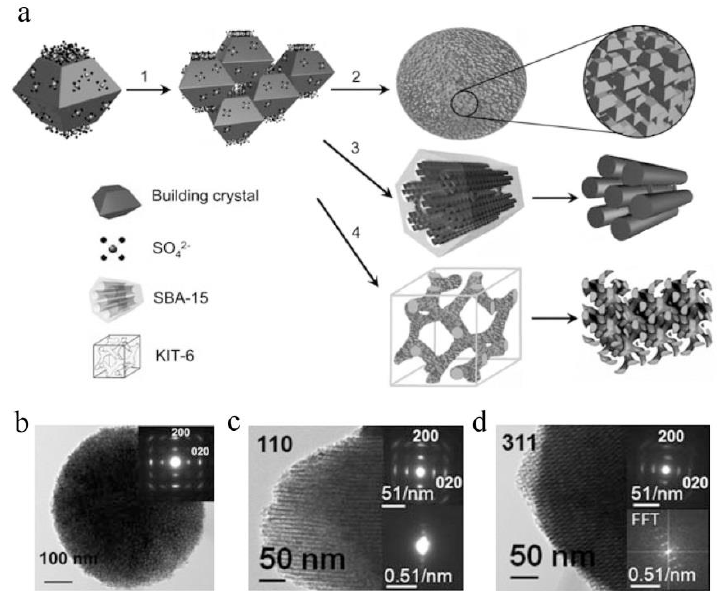
Figure 9. ( a ) Synthesis of mesoporous single-crystal-like anatase TiO 2 mesocrystals. (1) Formation of anatase clusters through oriented attachment of anatase nanocrystal building blocks with (001) facets preferably adsorbed by SO 42− ions. (2) Further attachment of the building blocks resulting in mesocrystals with preferential exposed (001) facets and disordered mesoporous structure. Mesocrystals with ordered mesoporous structure were prepared by a confined growth of the anatase crystals in (3) SBA-15 (mesoporous silica with 2D ordered pore channels) and (4) KIT-6 (mesoporous silica with 3D ordered pore channels) followed by scaffold removal. TEM images of anatase mesocrystals with disordered mesopores ( b ), mesoporous mesocrystals grown within SBA-15 ( c ) and KIT-6 ( d ) followed by removal of the scaffold. The insets in ( b – d ) show the related SAED and FFT patterns. Reprinted with permission from [130]. Copyright John Wiley & Sons Inc.,